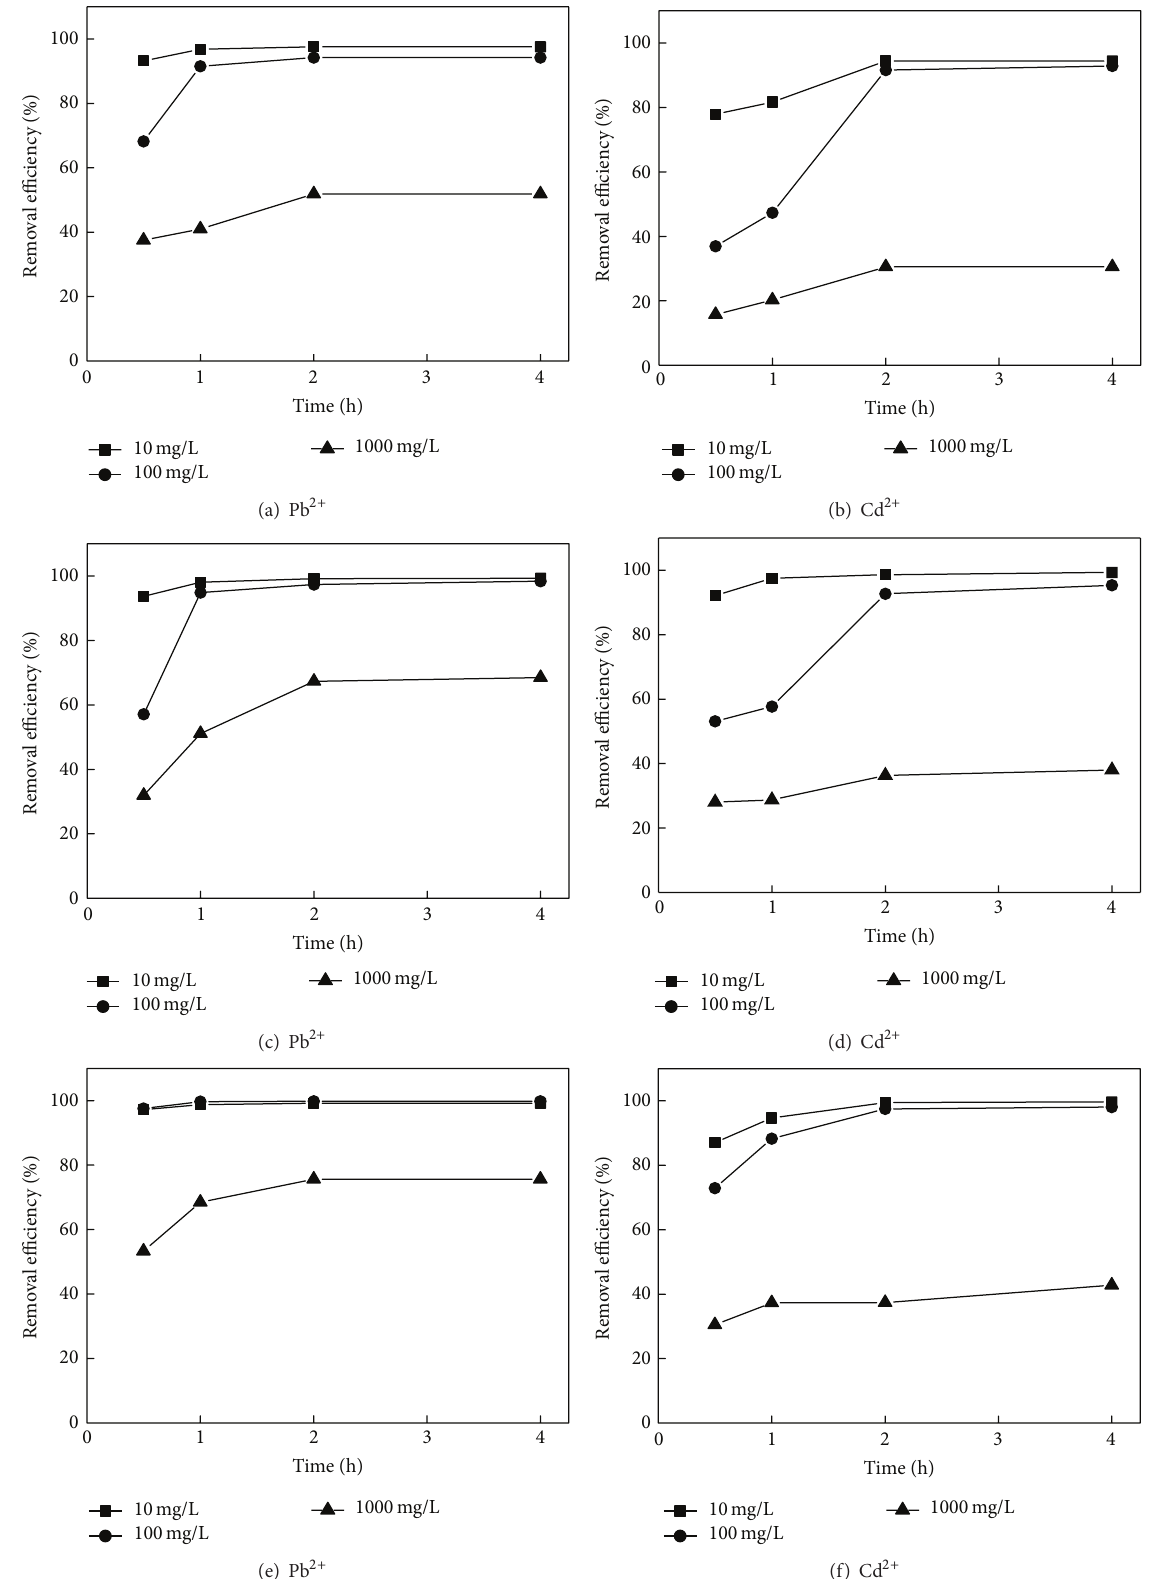
Figure 3: Removal characteristics of Pb 2+ and Cd 2+ by the HAp/chitosan hybrid fibers with different HAp contents according to initial concentration and reaction time: (a) and (b) 10/90, (c) and (d) 20/80, and (e) and (f) 30/70 HAp/chitosan hybrid